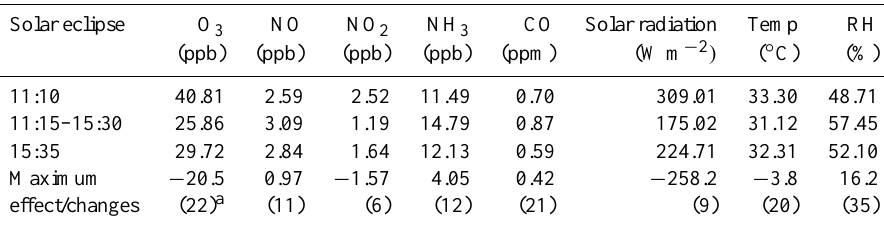
Table 1. Average concentration of surface O 3 , NO, NO 2 , NH 3 , CO, solar radiation, ambient temperature and relative humidity (RH) before, during and after the solar eclipse event with time lag from mid eclipse at Thiruvanthapuram, India.